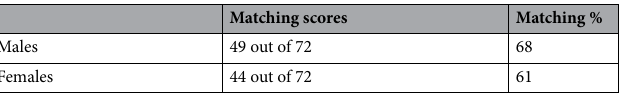
Table 6. Matching scores and percentages between MDP and real life prescriptions.